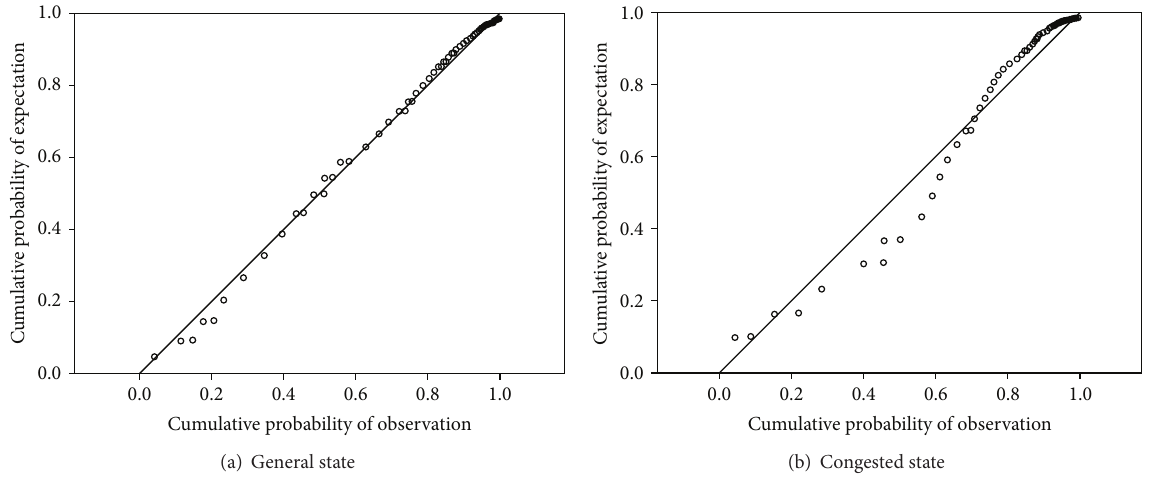
Figure 6: P-P figure of log-normal distribution fitting.